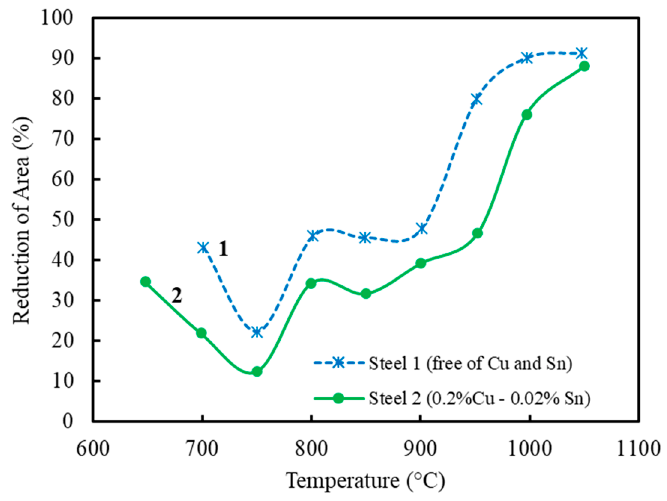
Figure 7. Influence of Cu and Sn on the hot ductility of steels [24].